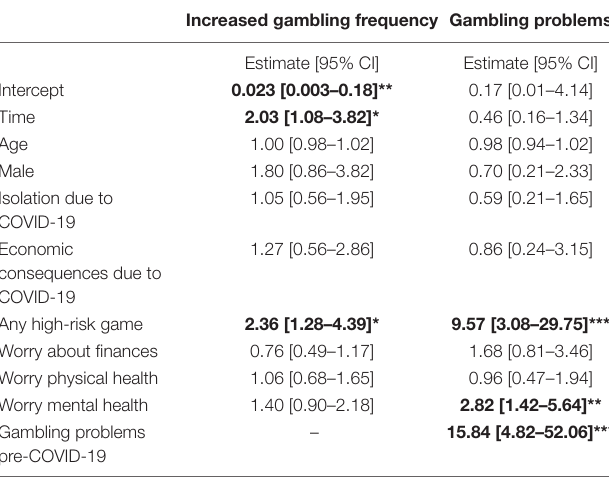
TABLE 4 | Logistic regression model output for change in gambling frequency and gambling problems from the first to the second